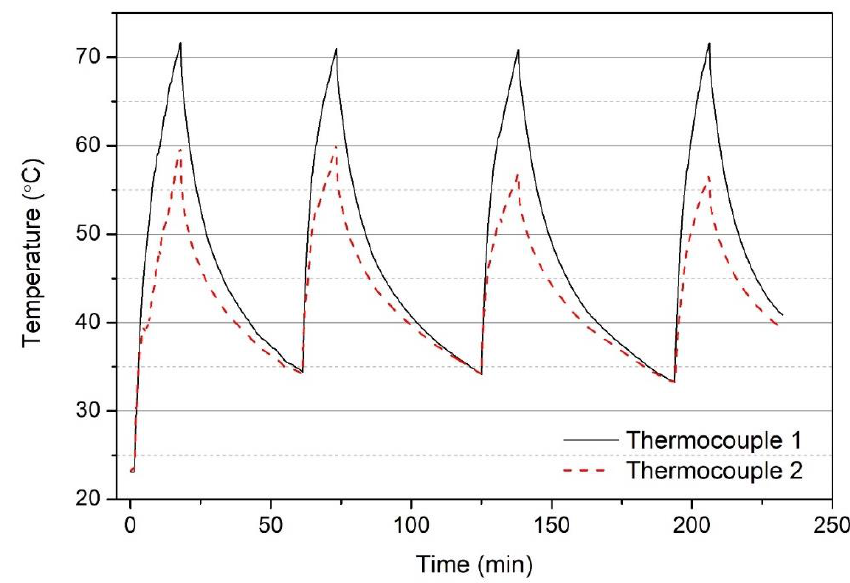
Figure 8. Temperature measured in the two pressure plates during four repetitions.